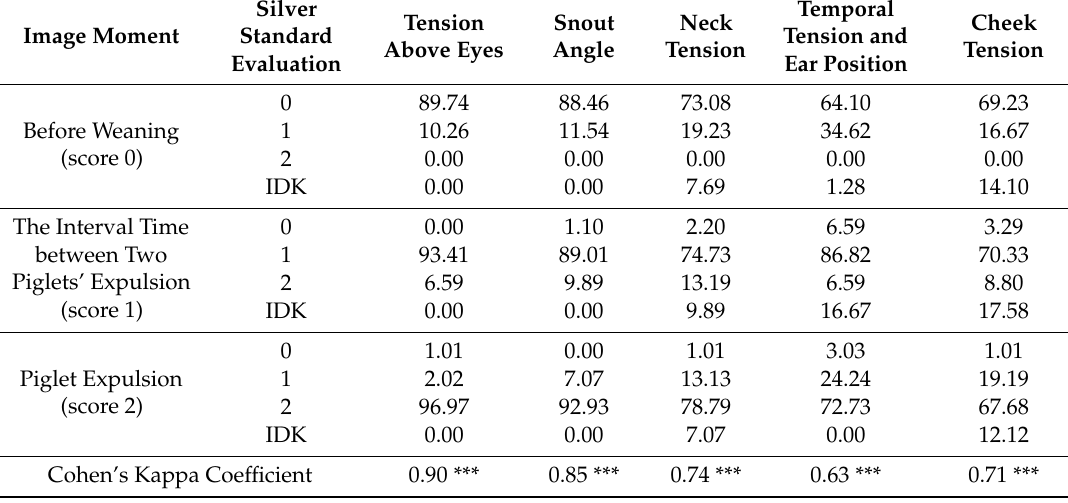
Table 1. Percentage of reliability and Kappa coe ffi cient between images and the silver standard evaluation in each FAU of 268 sow face images: 78 images from before weaning (score 0), 91 images from the interval time between two piglets’ expulsion (score 1), and 99 images from piglet expulsion (score 2). The silver standard evaluation was defined as follows: painless moment (score 0),